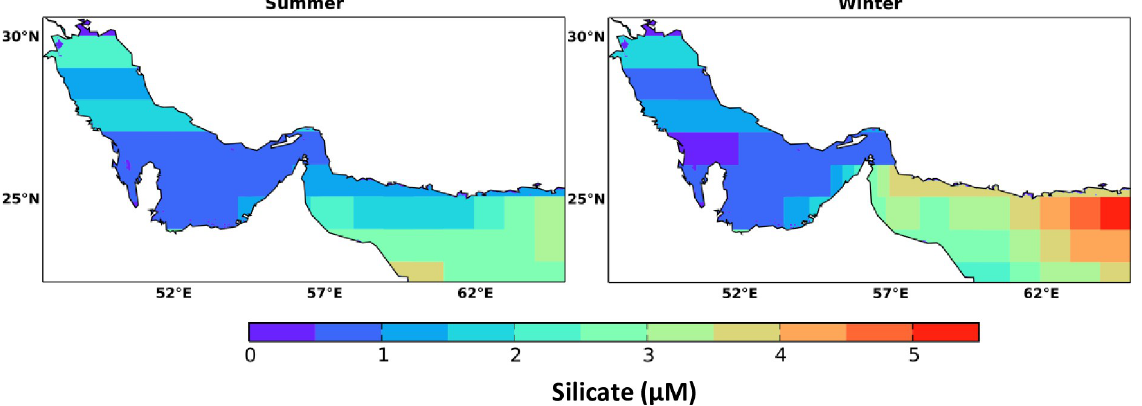
Fig 4. Seasonal spatial distribution of marine surface silicate in the Arabian Gulf and Sea of Oman extracted from the monthly climatology of the World Ocean Atlas data (WOA) for the year 2018. The WOA data are climatological data collected from the periods